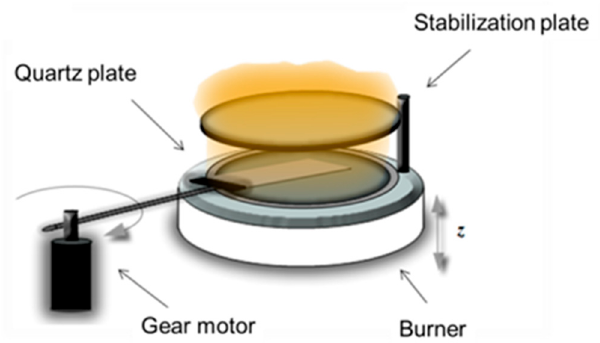
Figure 1. Scheme of the burner with the system for the thermophoretic sampling. Carbon particulate samples were scratched from the glass plate and extracted with dichloromethane (DCM, CH 2 Cl 2 ) (Sigma Aldrich, USA by Merck group, Darmstadt, Ger- many, purity > 99.9%) for separating organic species (soluble in DCM) from solid carbon particles insoluble in DCM, referred to as soot.